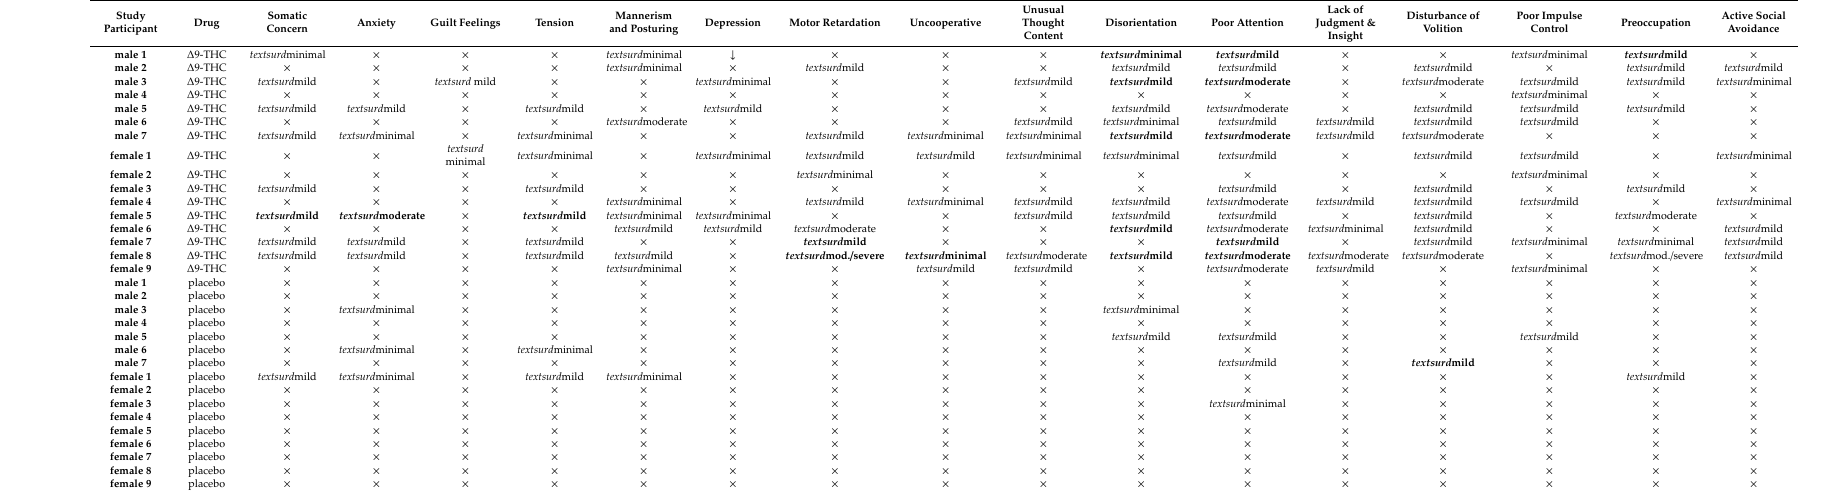
Table 3. Psychosis-related general